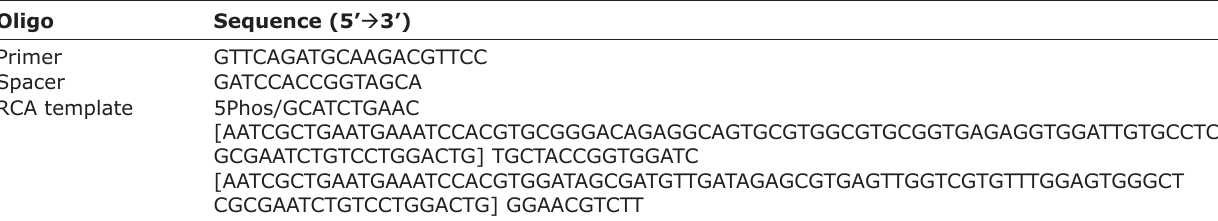
Table-1: Primer, RCA template, and spacer complementary sequences designs. The RCA template which is composed of the complementary sequences of the anti-ST and anti-SE aptamers[13] is flanked primer-binding sites and spacer region. Of course, the RCA template was ordered as phosphorylated to facilitate the T4 DNA ligase (NEB, Cat# M0202S). The primer was designed to span the primer-binding sites of the two extremities of the RCA